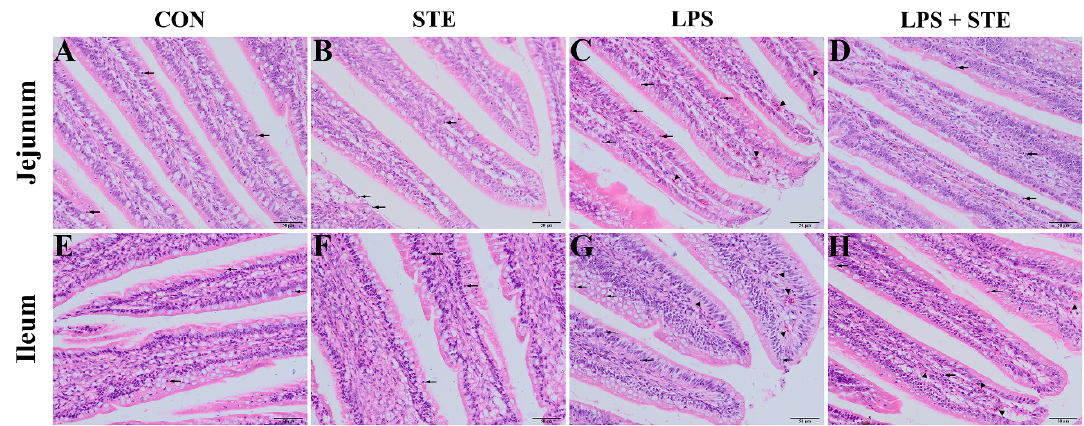
Figure 1. Representative images of jejunal ( A – D ) and ileal ( E – H ) morphology of D21 broilers. Triangle and arrow represent hyperemia and neutrophil infiltrations, respectively. CON, non-challenged broilers fed a basal diet; STE, non-challenged broilers fed a basal diet supplemented with 250 mg / kg stevioside; LPS, LPS-challenged broilers fed a basal diet; LPS + STE, LPS-challenged broilers fed a basal diet supplemented with 250 mg / kg stevioside. Scale bar = 50 µ